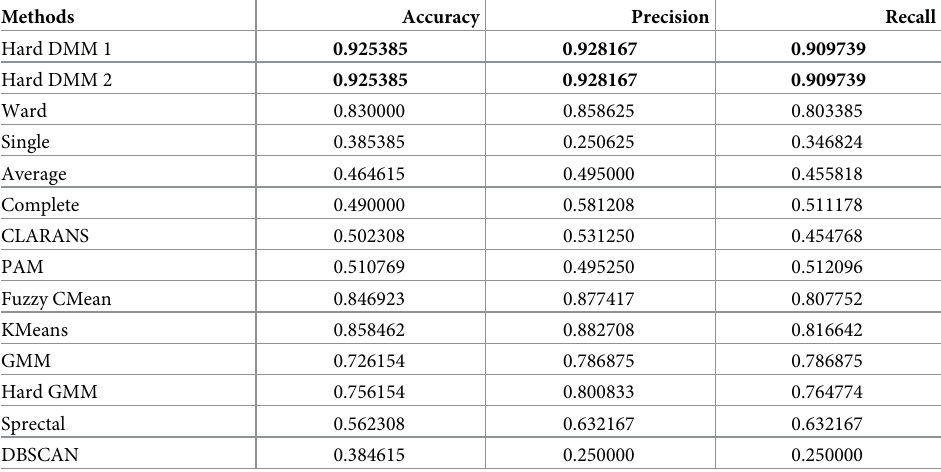
Table 2. Accuracy, precision and recall of different clustering algorithms on data generated under scheme 2.